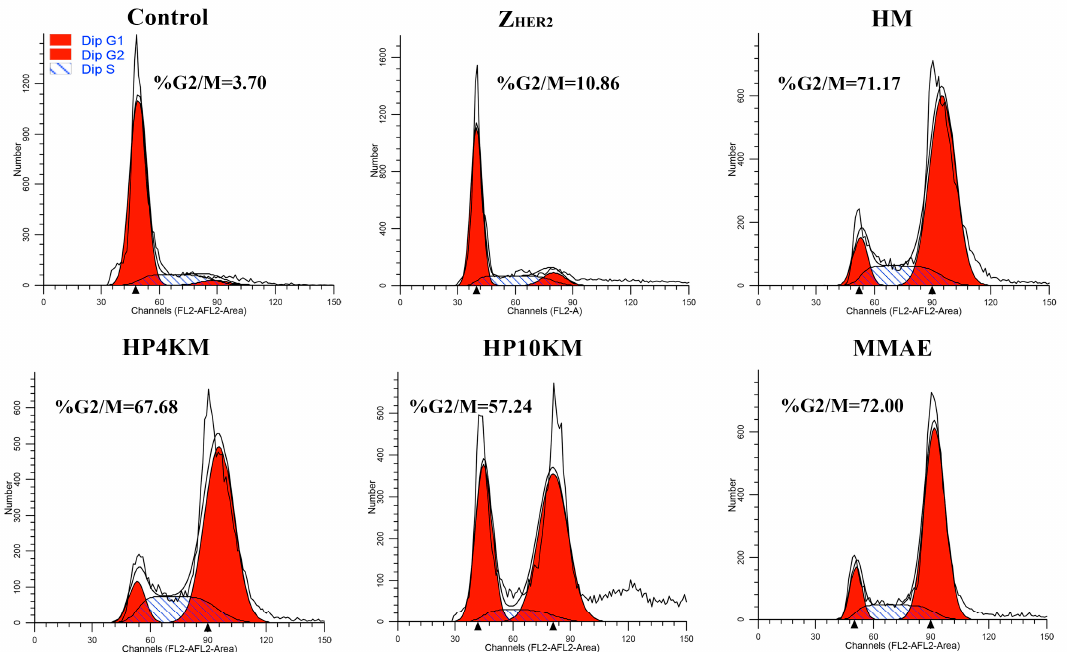
Figure 6. Selective induction of G2 growth arrest by these conjugates. NCI-N87 cells were exposed to 1.0 µ M conjugates, 1.0 µ M Z HER2:2891 affibody or free MMAE for 16 h before analysis by flow cytometry. %G2/M indicates the percentage of cells arrested at the G2/M phase.